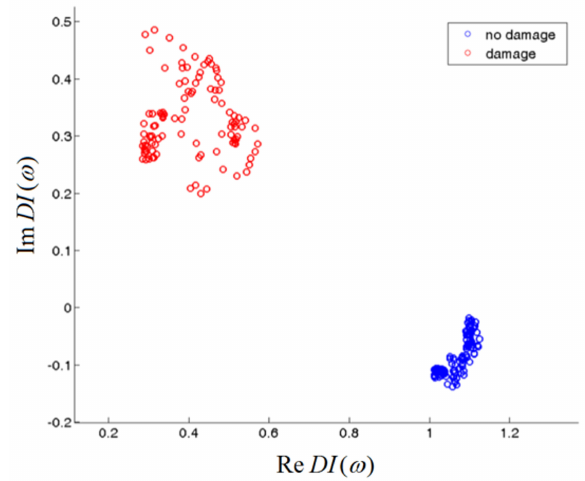
Figure 4. Example of DIs obtained for the pristine state of the structure and when a damage is